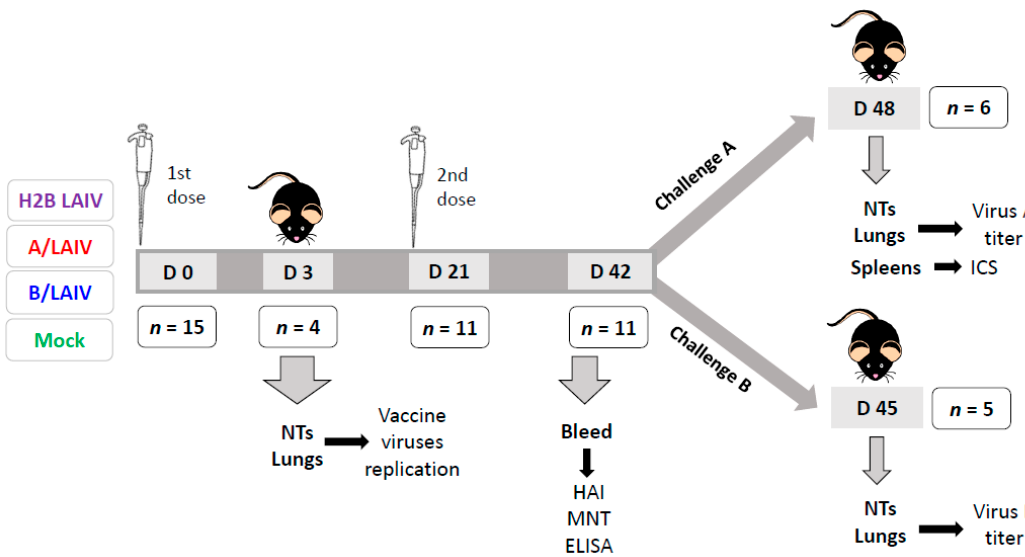
Figure 1. Experiment design scheme: the mice were twice immunized with experimental chimeric (H2B) vaccine or control live attenuated influenza vaccines (LAIVs). On day 3 after immunization, vaccine virus titers in the organs were assessed in 4 animals from each group. Three weeks after the second immunization, the animals were challenged with influenza A or B virus. Five animals stayed naïve for negative controls. Viral loads in the lungs were studied on day 3 (for influenza B) and day 5 (for influenza A) after the challenge. The number of animals in each group is indicated in frames.